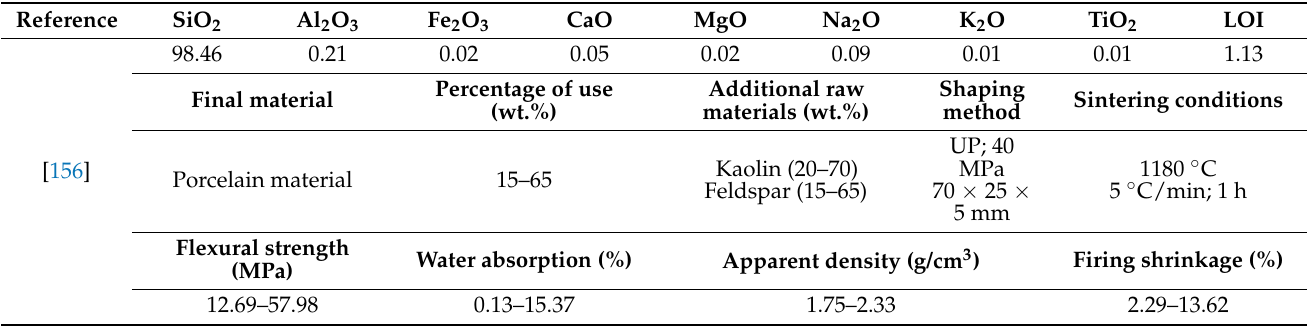
Table 26. Chemical composition (expressed wt.% oxide), processing parameters and technological properties of ceramic materials developed from agate